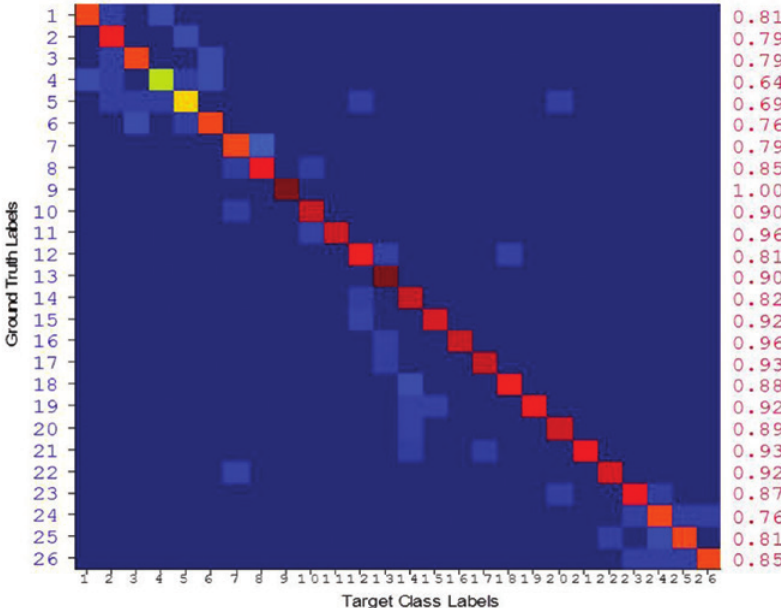
Figure 4: Confusion Matrix Obtained for (60:40) Training and Testing Samples.